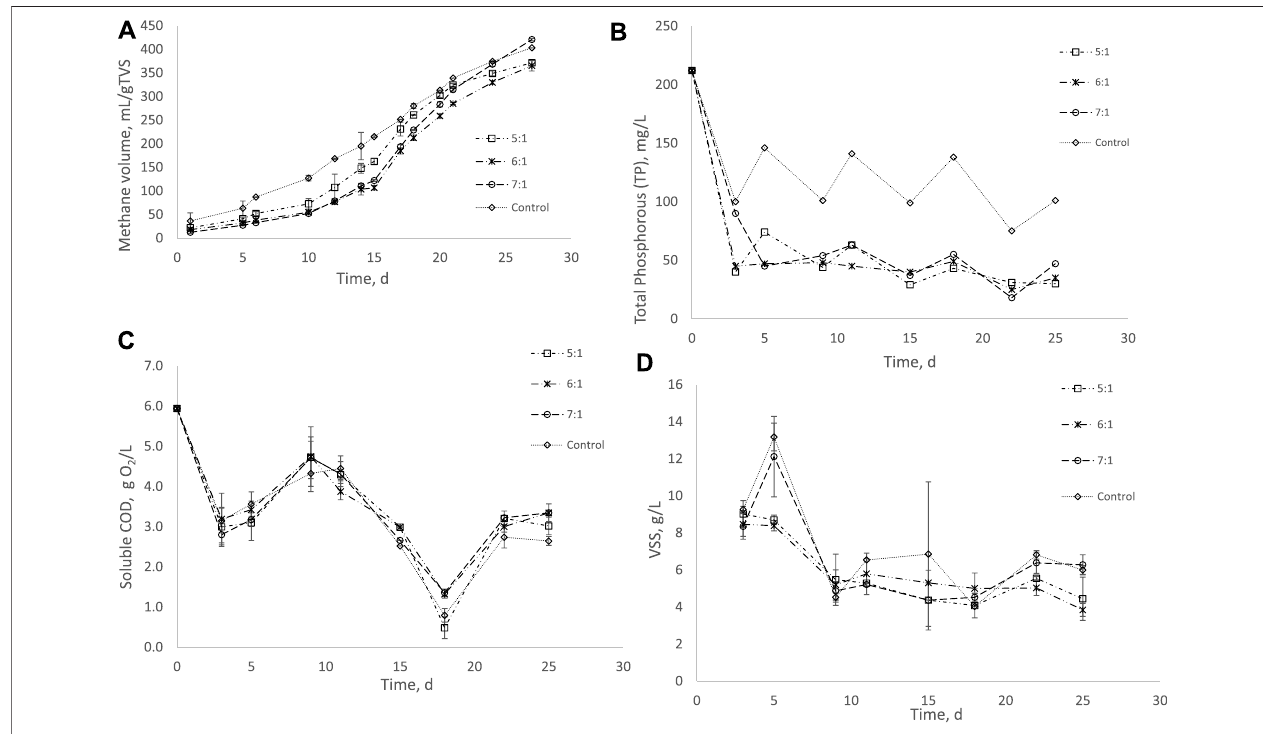
FIGURE 1 | (A) : Variation in methane volume with digestion time in the assays at different bischo fi te: P ratios. (B) : Total phosphorous pro fi les with different bischo fi te: P ratios. (C) : Soluble COD pro fi les with different bischo fi te: P ratios. (D) : Volatile suspended solid (VSS) pro fi les with different bischo fi te: P ratios.